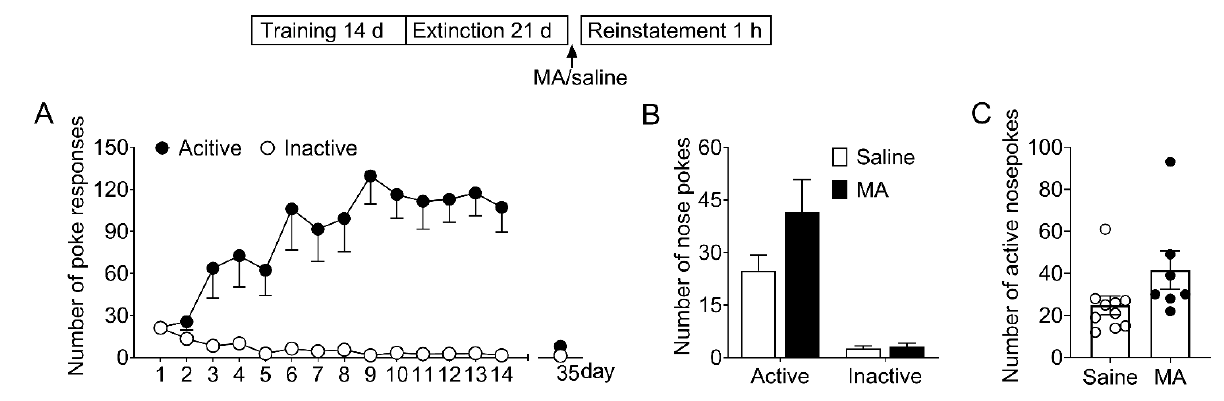
Figure 6. Intravenous injection of MA before the reinstatement test had no significant effect on the reinstatement of saccharin-seeking behavior induced by noncontingent saccharin delivery. ( A ) Number of nose-pokes in the 14 training sessions (days 1–14) and the last extinction session (day 35). ( B ) Number of nose-pokes in saline group ( n = 10) and MA group ( n = 7) in the reinstatement session. There was no significant difference in the number of nose-pokes between the two groups. Data are expressed as mean ± SEM. ( C ) Number of active nose-pokes of each individual in the reinstatement session. MA: n = 7; Saine: n =10.